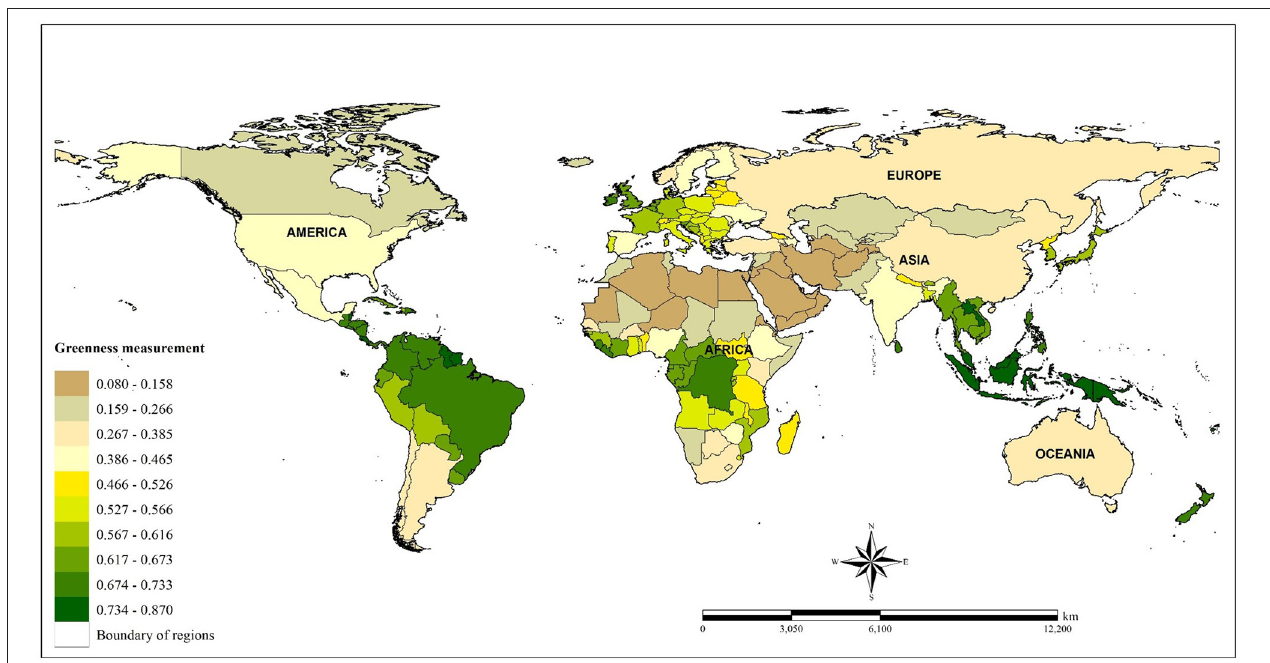
FIGURE 2 | Spatial distribution of global greenness based on average of NDVI (crude) assessment from four study periods (2000, 2010, 2015,